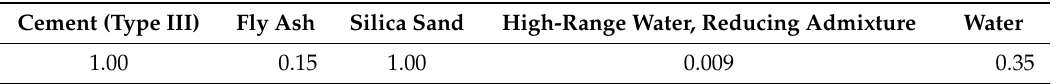
Table 5. Composition of the mortar.